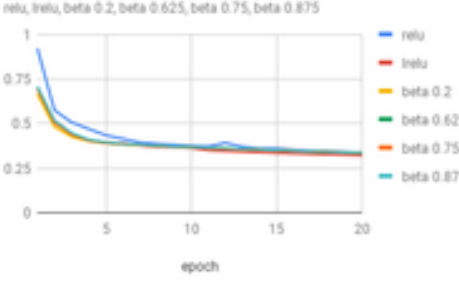
Figure 4. Graphical Representation of LReLU and e-swish with reference to